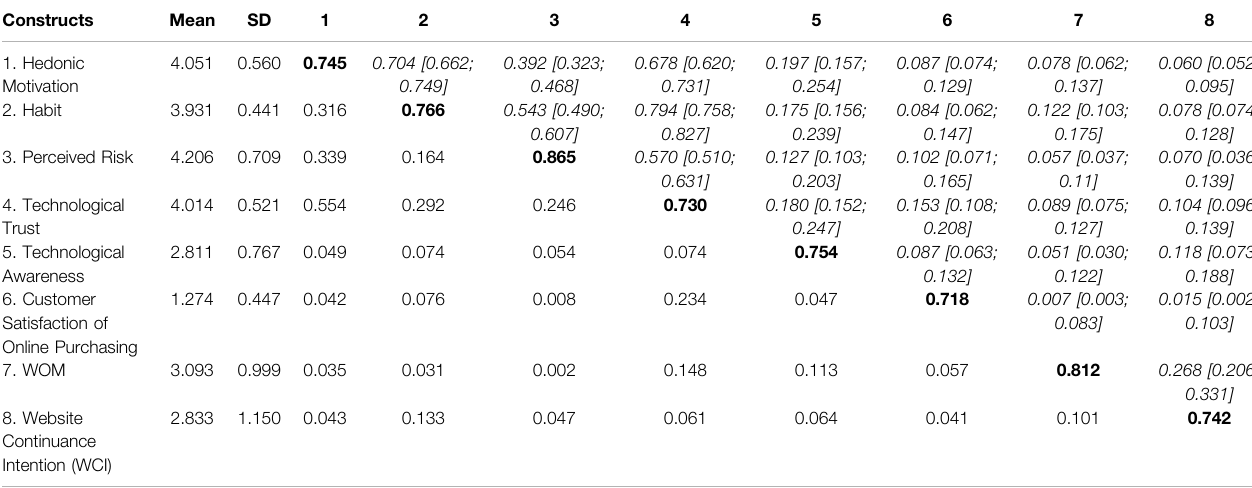
TABLE 3 | Descriptive statistics, correlation matrix, and discriminant validity. Constructs